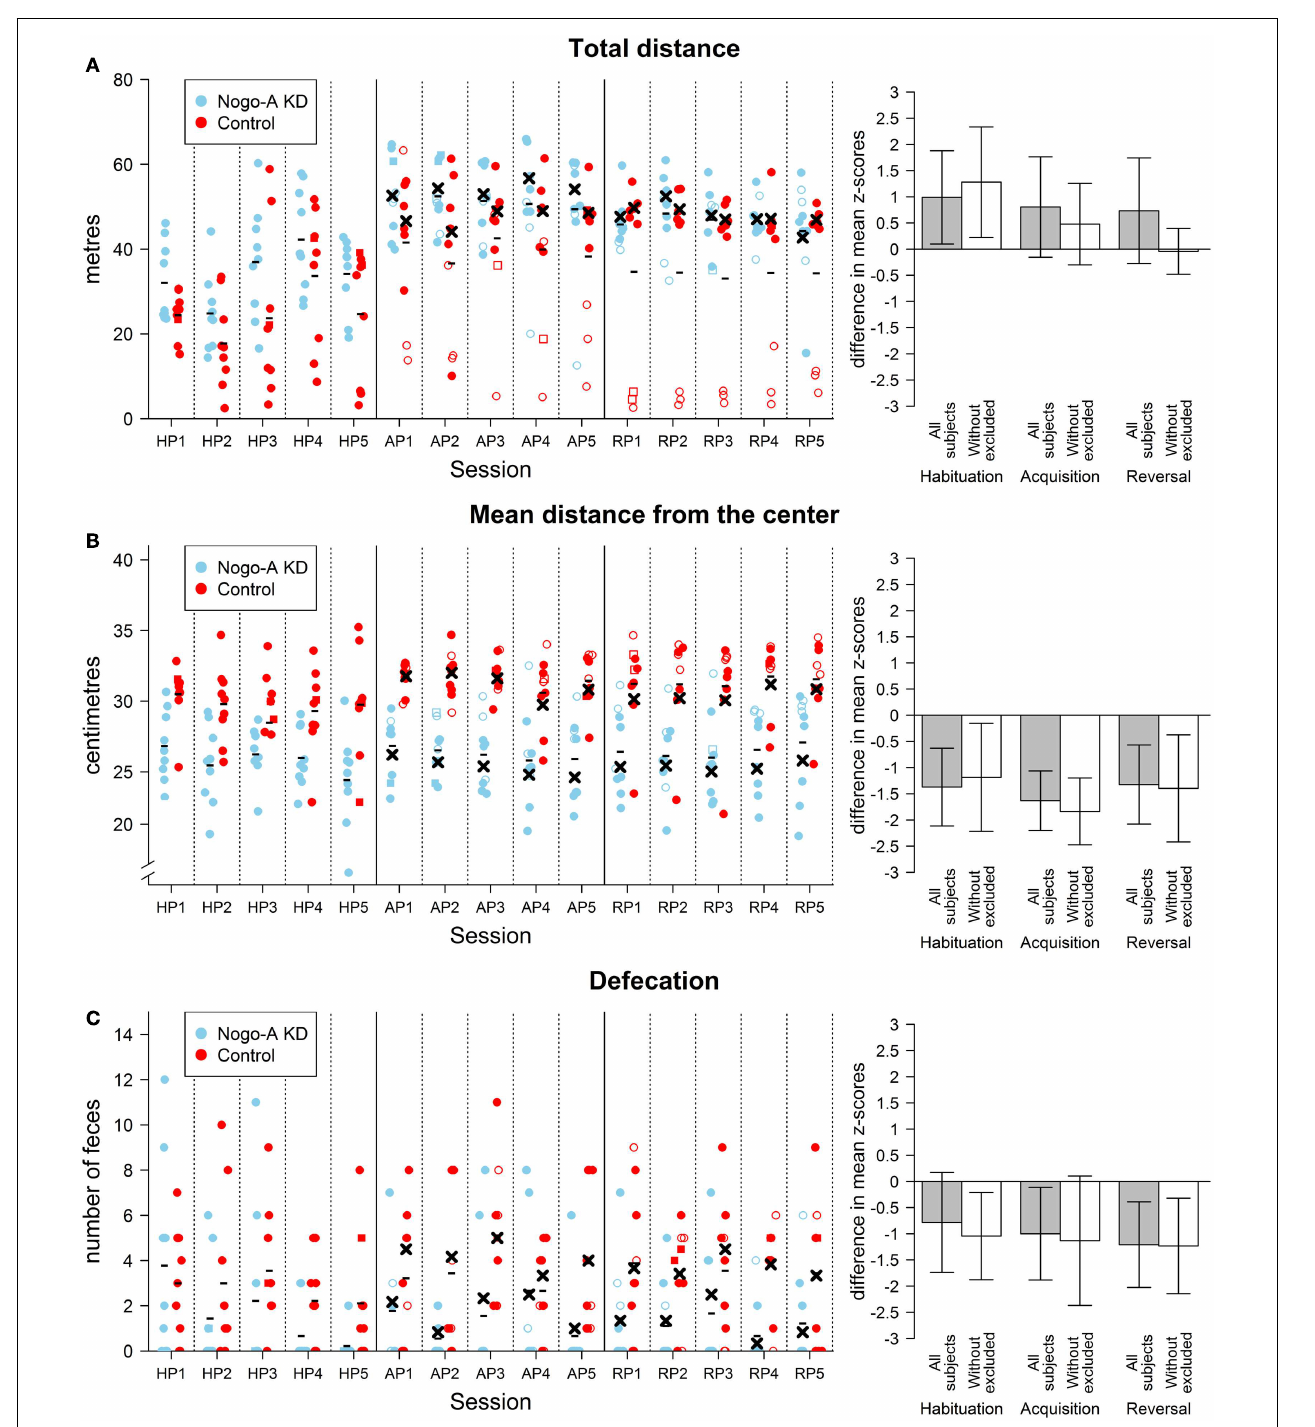
in the text. For the acquisition and reversal phases, empty points indicate values for subjects that were excluded from analysis (see text for details). Minus signs indicate mean group values for a given session computed from all subjects and crosses indicate mean values computed from values without the excluded subjects.The means are computed from values including the imputed. For the habituation phase, no subjects were excluded from the analyses; therefore, only mean values computed for all subjects in a group are